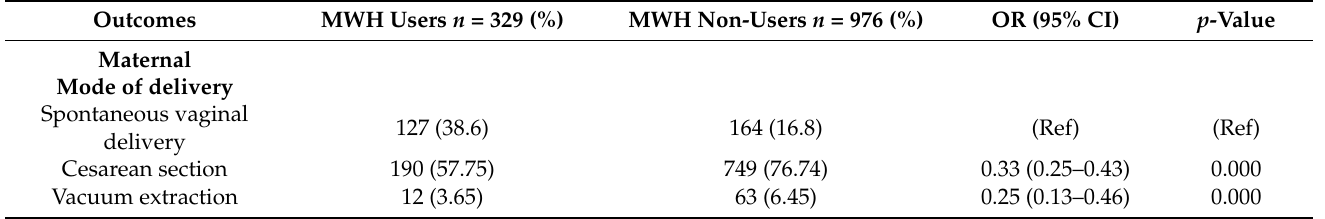
Table 3. Odds ratios for maternal and perinatal outcomes between users and